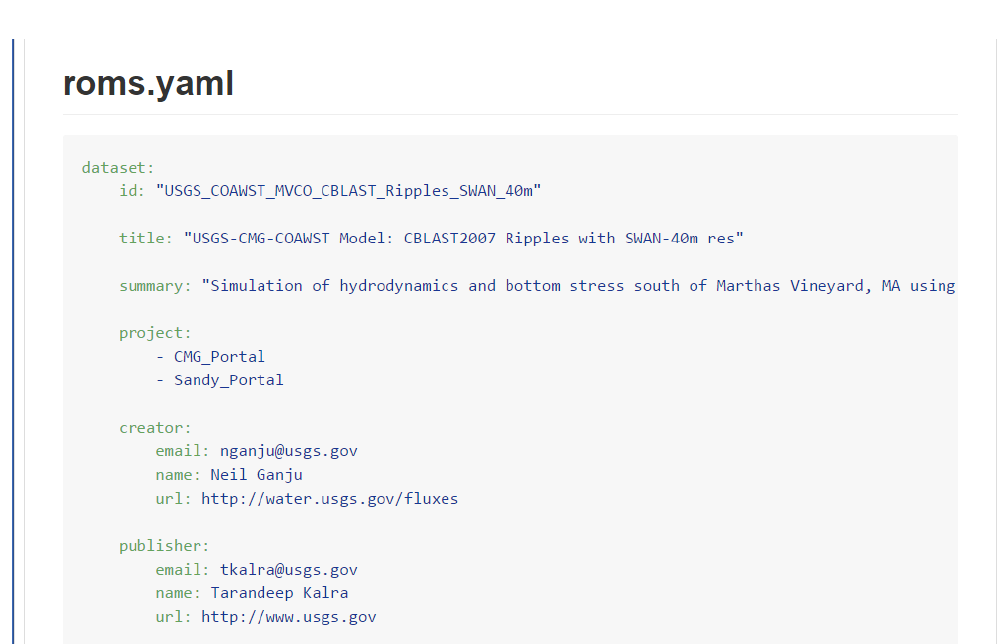
Figure 7. Example of a YAML file, created by the modeller and used to specify simulation-specific parameters. This YAML file is converted into NcML using the yaml2roms Python script. By specifying “CMG_Portal” in the project section, the modeller is indicating that this data set should be included in the USGS CMG_Portal web